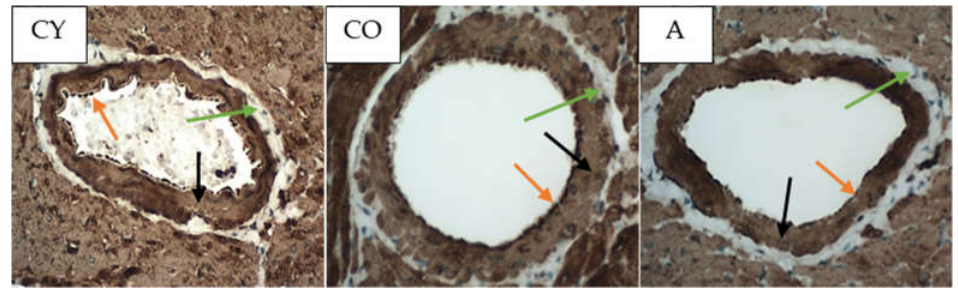
Figure 6. Myocardium. Coronary arteries of left ventricle of rat heart, ACE2 immunoexpression, magnification ×400. Orange arrows indicate tunica intima, black arrows—tunica media, green arrows—tunica adventitia.